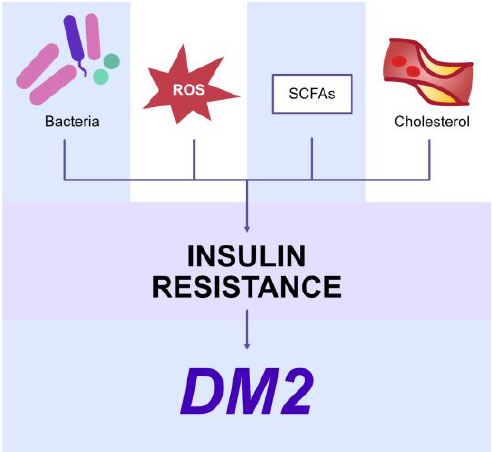
Figure 3. The involvement of oral microbiome dysbiosis in the development of diabetes mellitus. ROS — reactive oxygen species, SCFAs — short-chain fatty acids, DM2 — diabetes mellitus type 2.